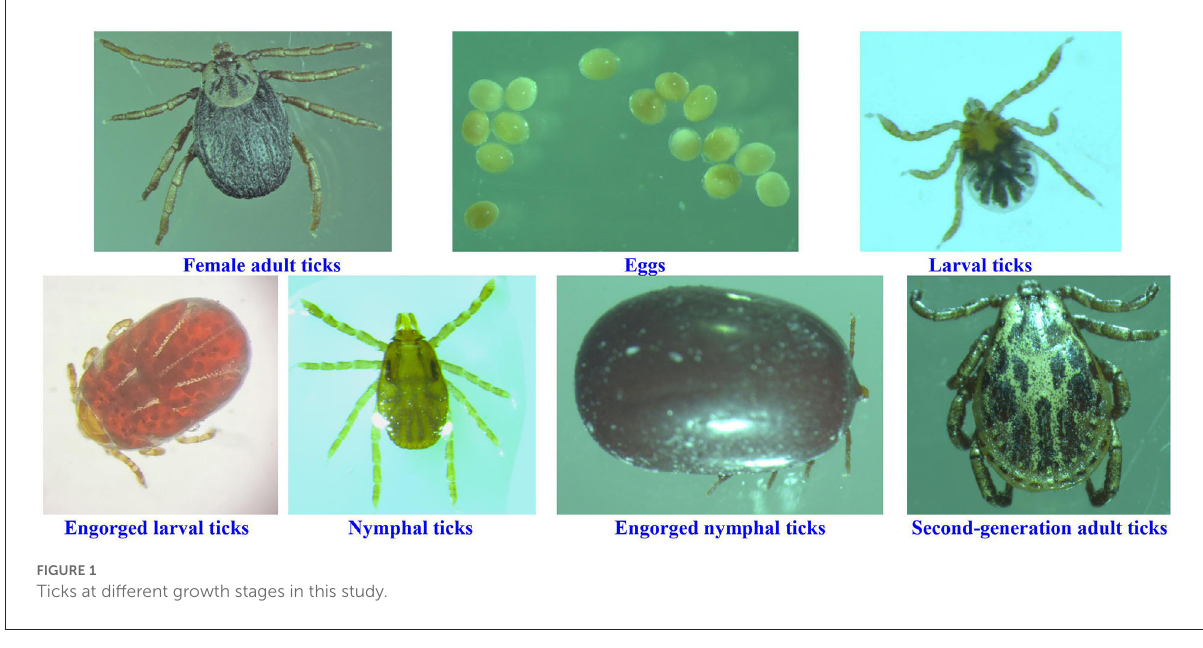
FIGURE1 Ticks at different growth stages in this study.